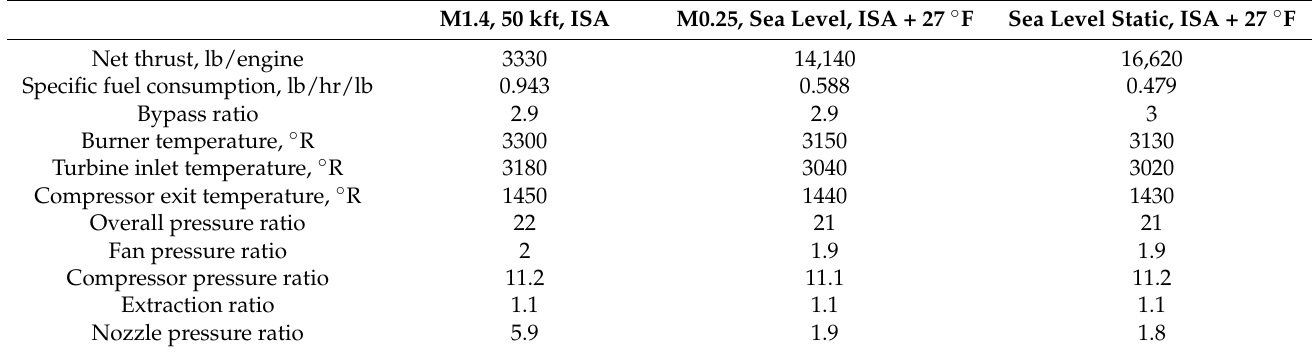
Table 1. Engine performance summary provided by NASA, reprinted from Ref. [11].